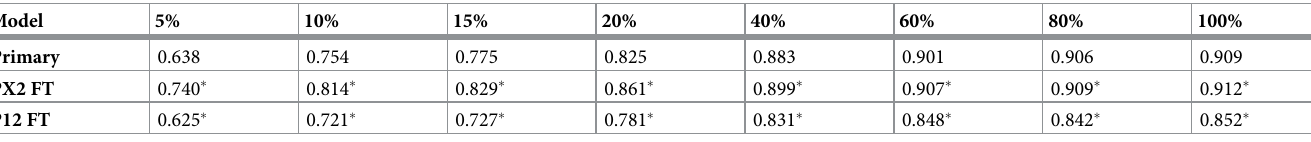
Table 3. Model performance using ablated primary dataset (overall soft Dice